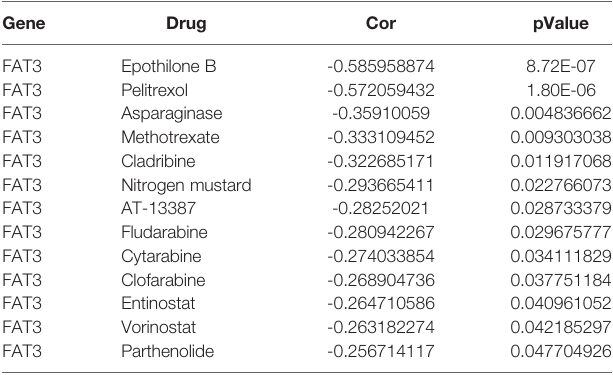
TABLE 2 | Analysis of the relationship between the expression level of target gene FAT3 and clinical drug sensitivity. Gene